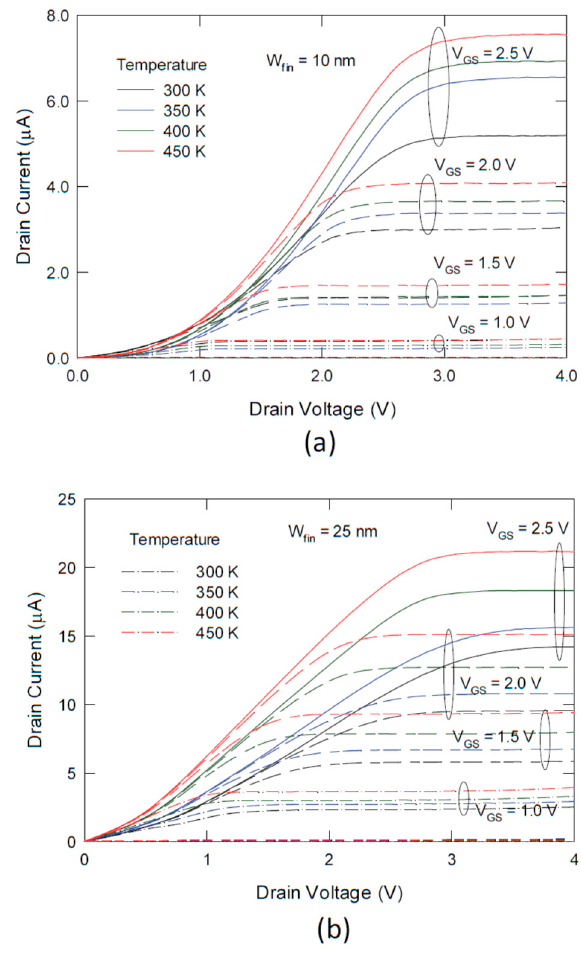
Figure 2. Plot of the current–voltage characteristics of nanowire transistor at different temperatures for nanowire widths of: ( a ) 10 nm, and ( b ) 25 nm. The gate length of the transistors was 1.5 μ m.